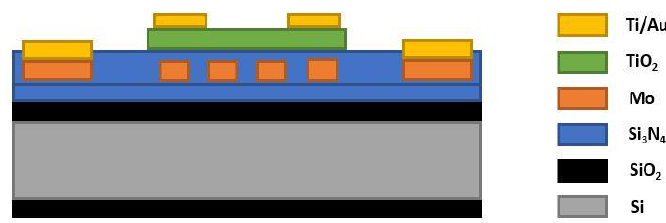
Figure 16. MEMS micro gas sensor device cross-section before etching.